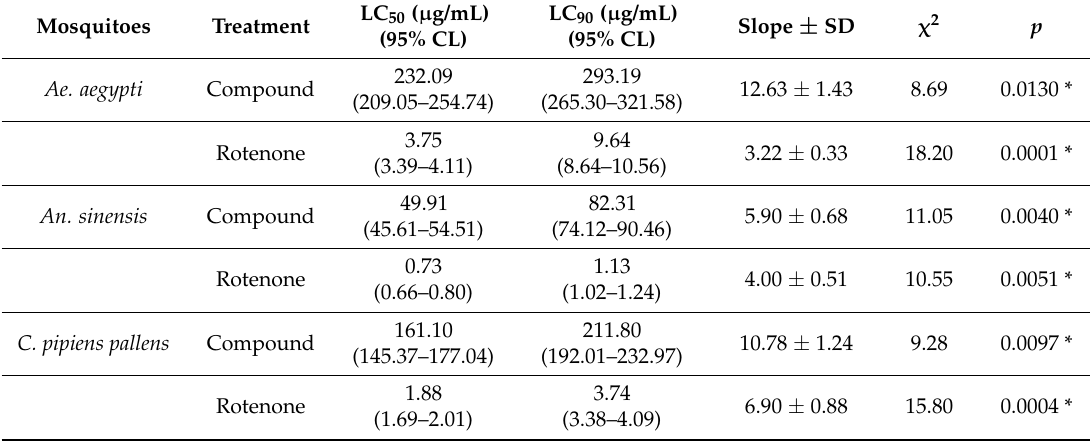
Table 2. Larvicidal activity of the isolated pyrrolidine alkaloid against the fourth instar larvae of Aedes aegypti , Anopheles sinensis , and Culex pipiens pallens .